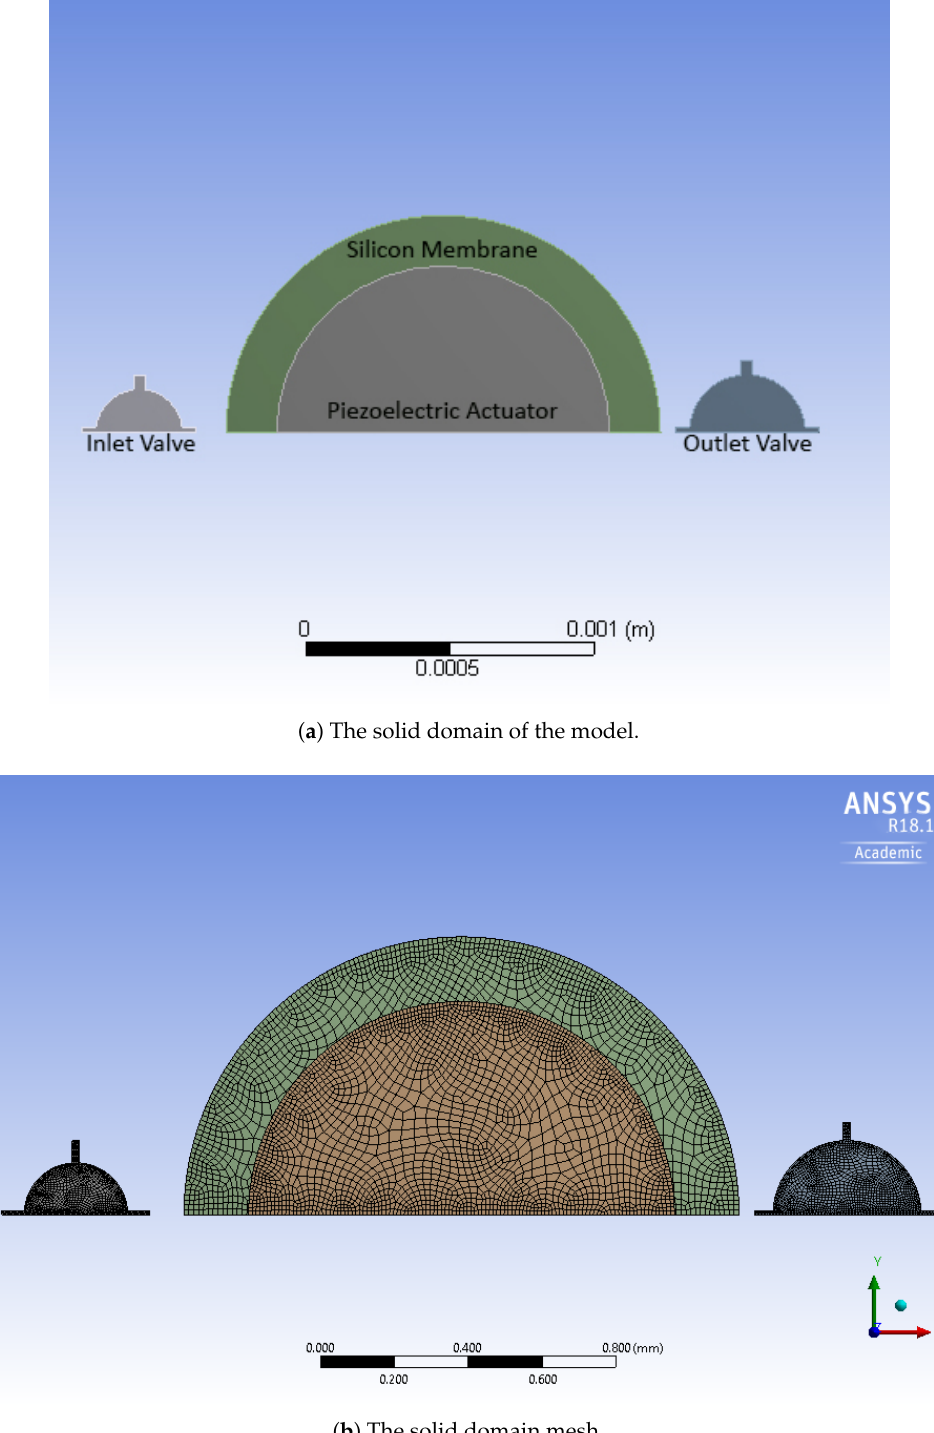
Figure 4. The micropump structural